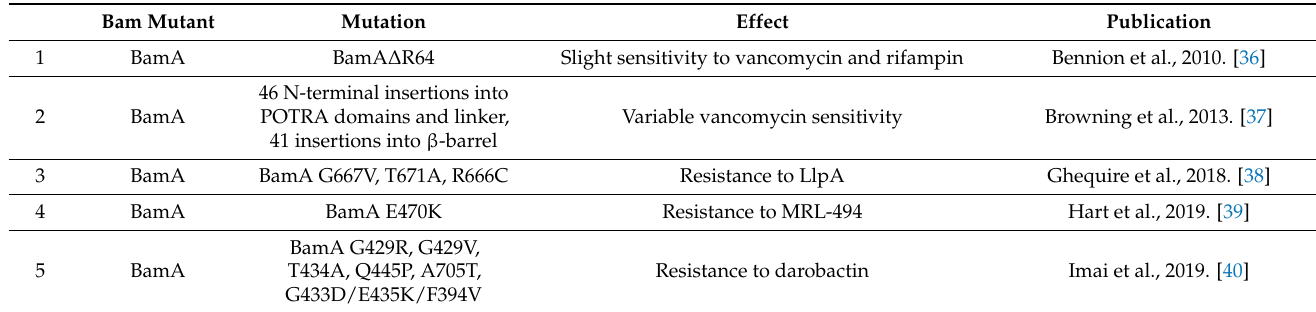
Table 1. Important mutations that disrupt BAM function. Summary of select mutants in Bam proteins that disrupted function and/or led to enhanced sensitivity to existing antibiotics (BamA (formerly called YaeT); BamB (formerly called YfgL); BamC (formerly called NlpB); BamD (formerly called YfiO); BamE (formerly called